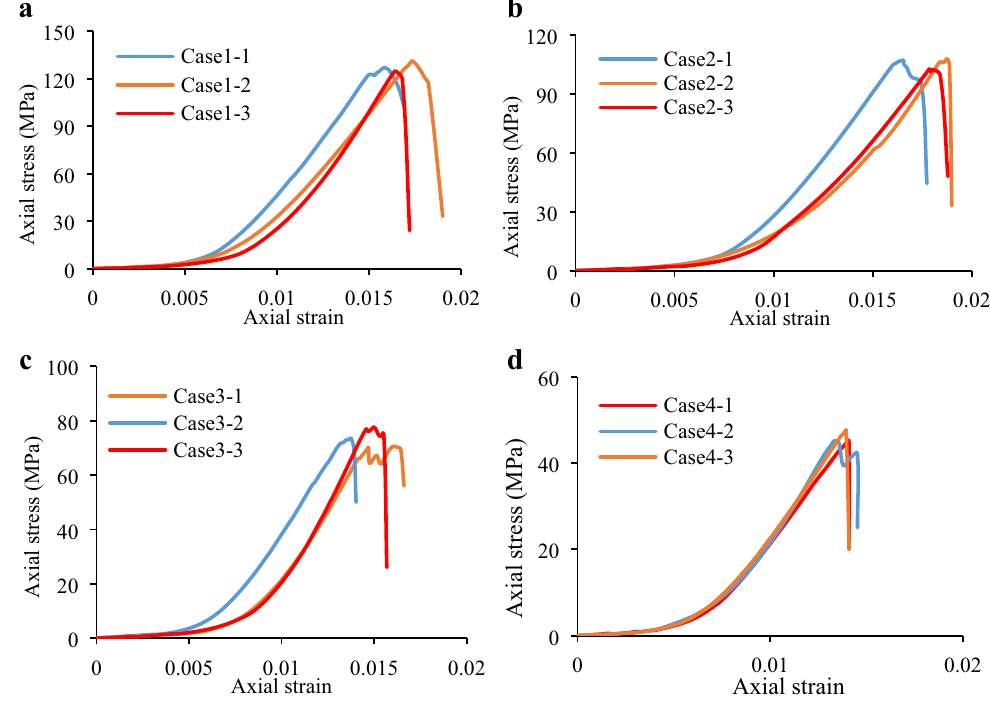
Figure 6. Granite specimen axial stress–strain curves at different inclination angles: ( a ) Under uniaxial compression; ( b ) 5°; ( c ) 10°; and ( d ) 20°.